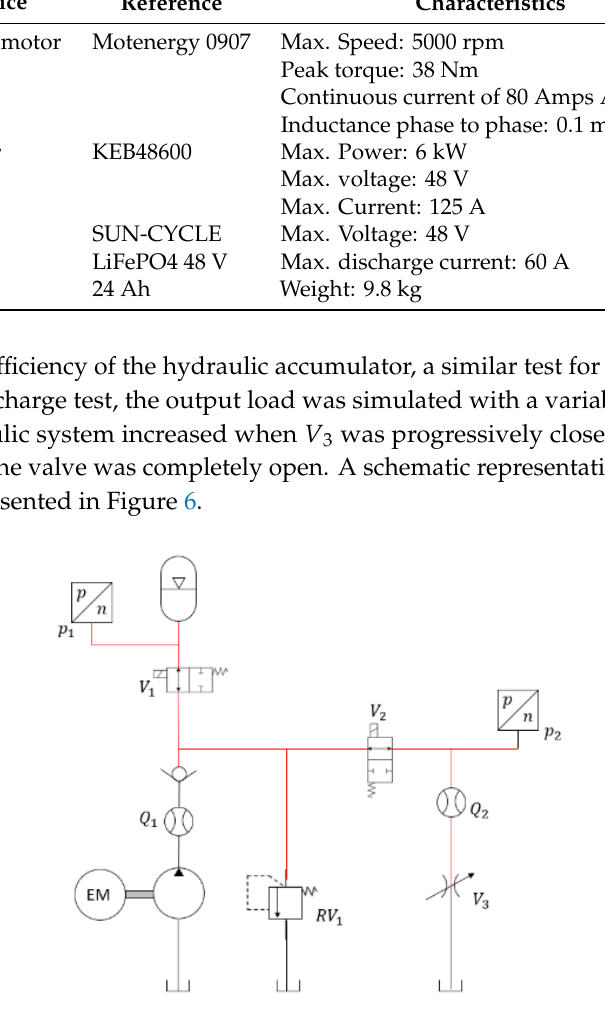
Table 5. Variables used for determining the instantaneous efficiency of the accumulator.